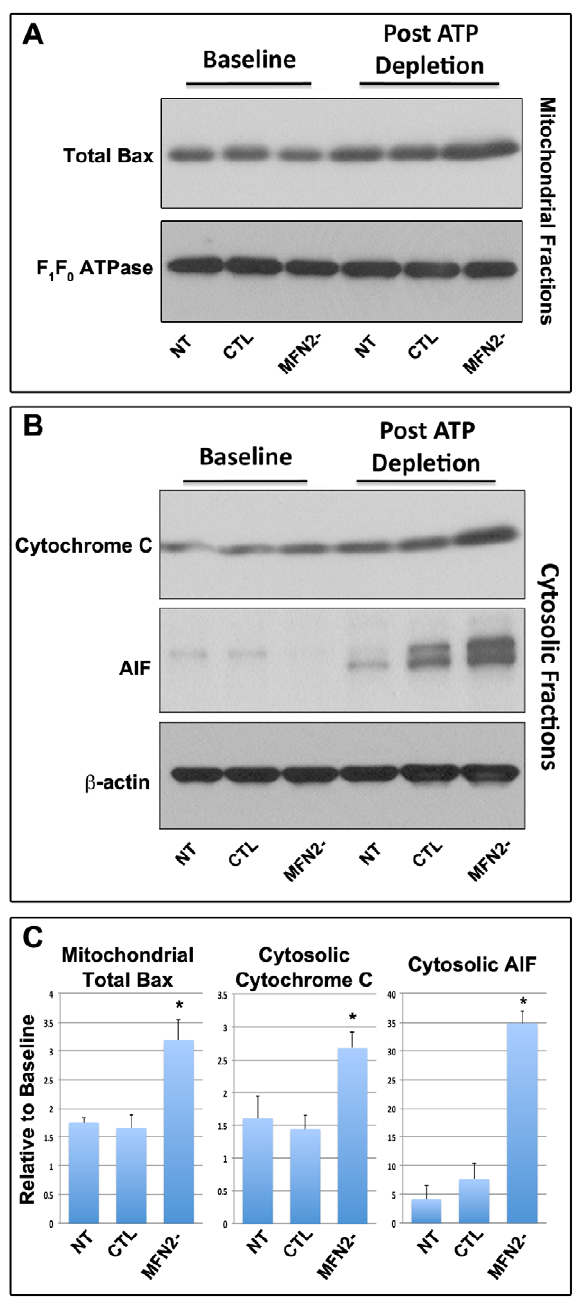
Figure 9. Effect of MFN2 deficiency on mitochondrial Bax translocation, and outer membrane injury. ( A ) Immunoblot of Bax ( upper panel ) in mitochondrial membrane fractions of MFN2 f/f proximal tubule epithelial cells exposed to no virus ( NT ), empty virus ( CTL ) or Cre adenovirus ( MFN2- ) at baseline and 30 min post ATP-depletion; F 1 F 0 ATPase serves as loading control ( lower panel ). ( B ) Immunoblot analysis of cytochrome c ( upper panel ) and Apoptosis Inducing Factor (AIF) ( middle panel ) in cytosolic fractions harvested from non-viral transduced cells ( NT ) or cells transduced with either empty virus ( CTL ) or Cre adenovirus ( MFN2- ) at baseline and 30 min after ATP depletion. ß-actin loading control ( lower panel ). ( C ) Densitometric analysis of mitochon- drial Bax accumulation as well as the leakage of cytochrome c and AIF in renal tubule epithelial cells after ATP depletion; data represent the mean and SE of 4 separate experiments; P ,